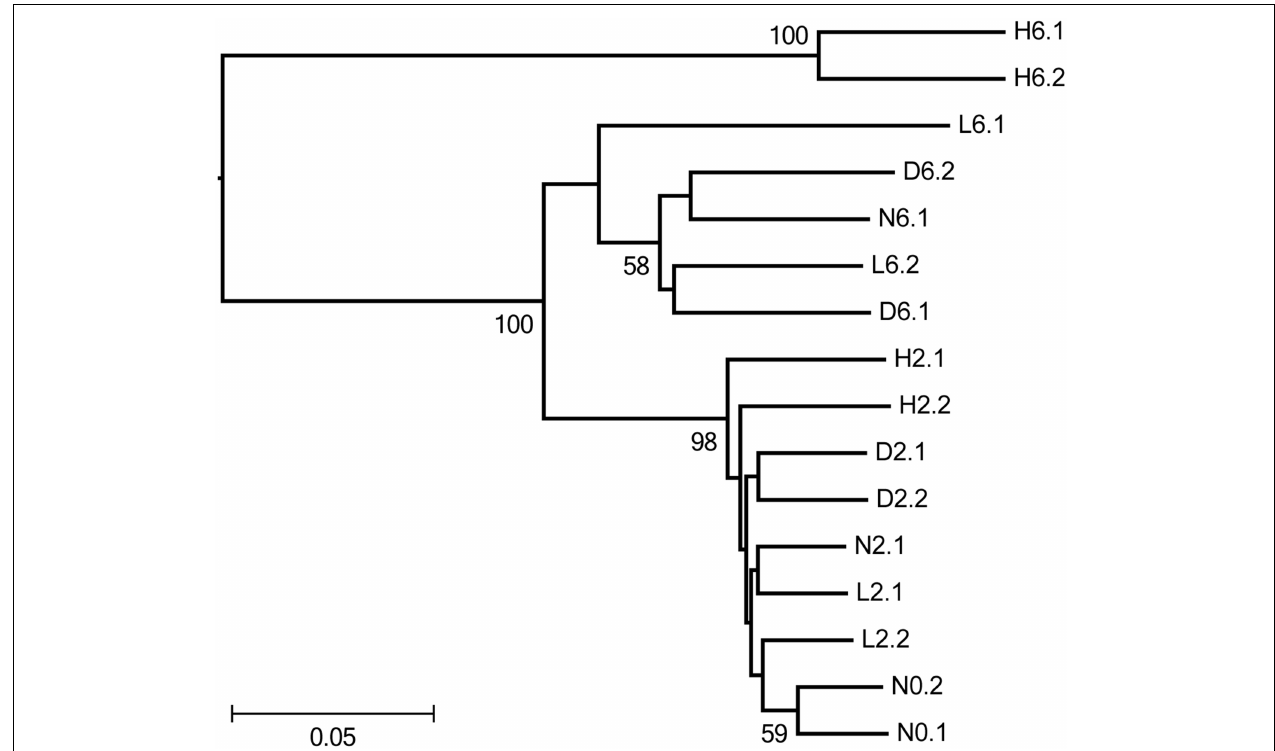
FIGURE 1 | Jackknifed UPGMA clustering (using the weighted UniFrac metric) showing the similarity of sponge-associated bacterial communities based on pyrosequenced 16S rRNA genes. Bootstrap values > 50 are shown at the nodes. N, D, L, and H